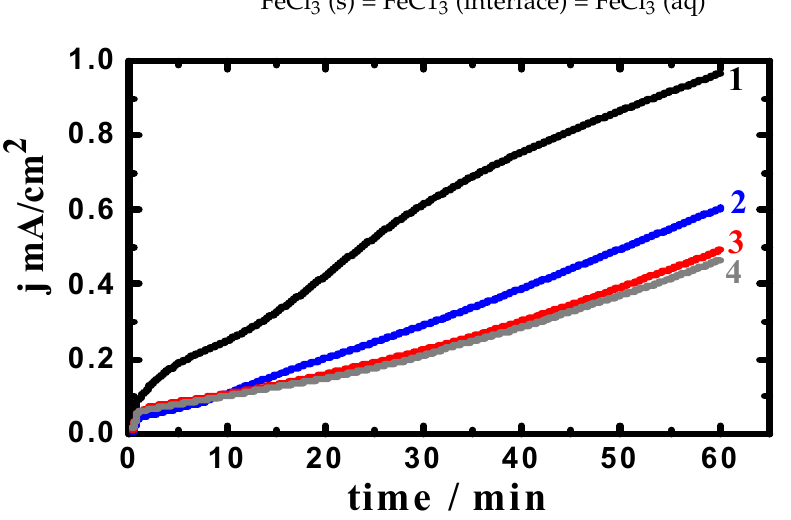
Figure 4. Current–time curves collected at − 475 mV (Ag/AgCl) for an iron rod in 3.5% NaCl solutions containing (1) 0.0 MAO, (2) 5 × 10 − 5 M MAO, (3) 1 × 10 − 4 M MAO, and (4) 5 × 10 − 5 M MAO after 1 h immersion.